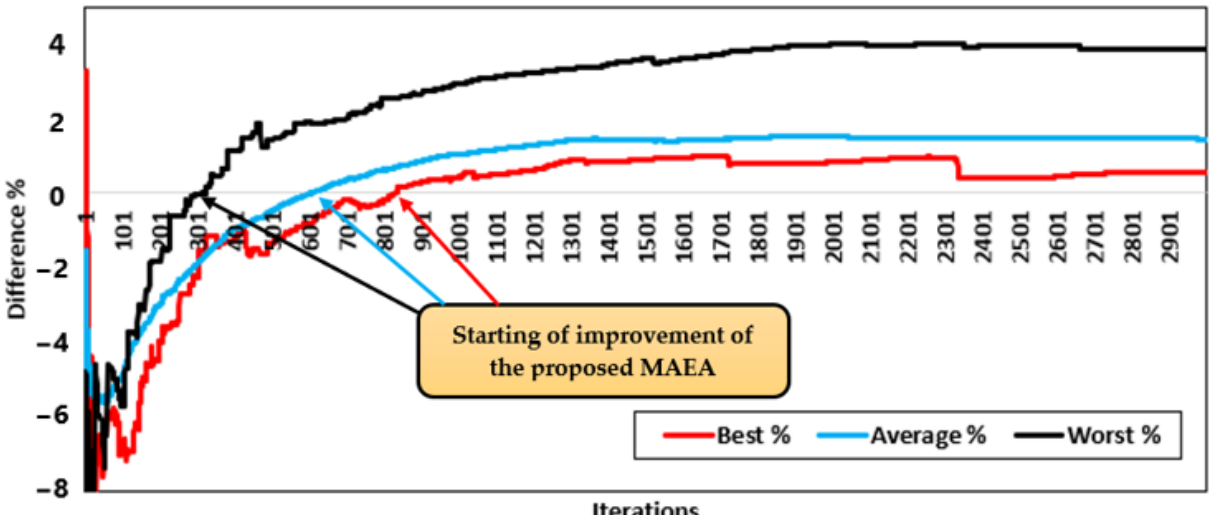
Figure 15. Percentage difference for the worst run and the average of all runs of the MAEA and AEA of Case 4.